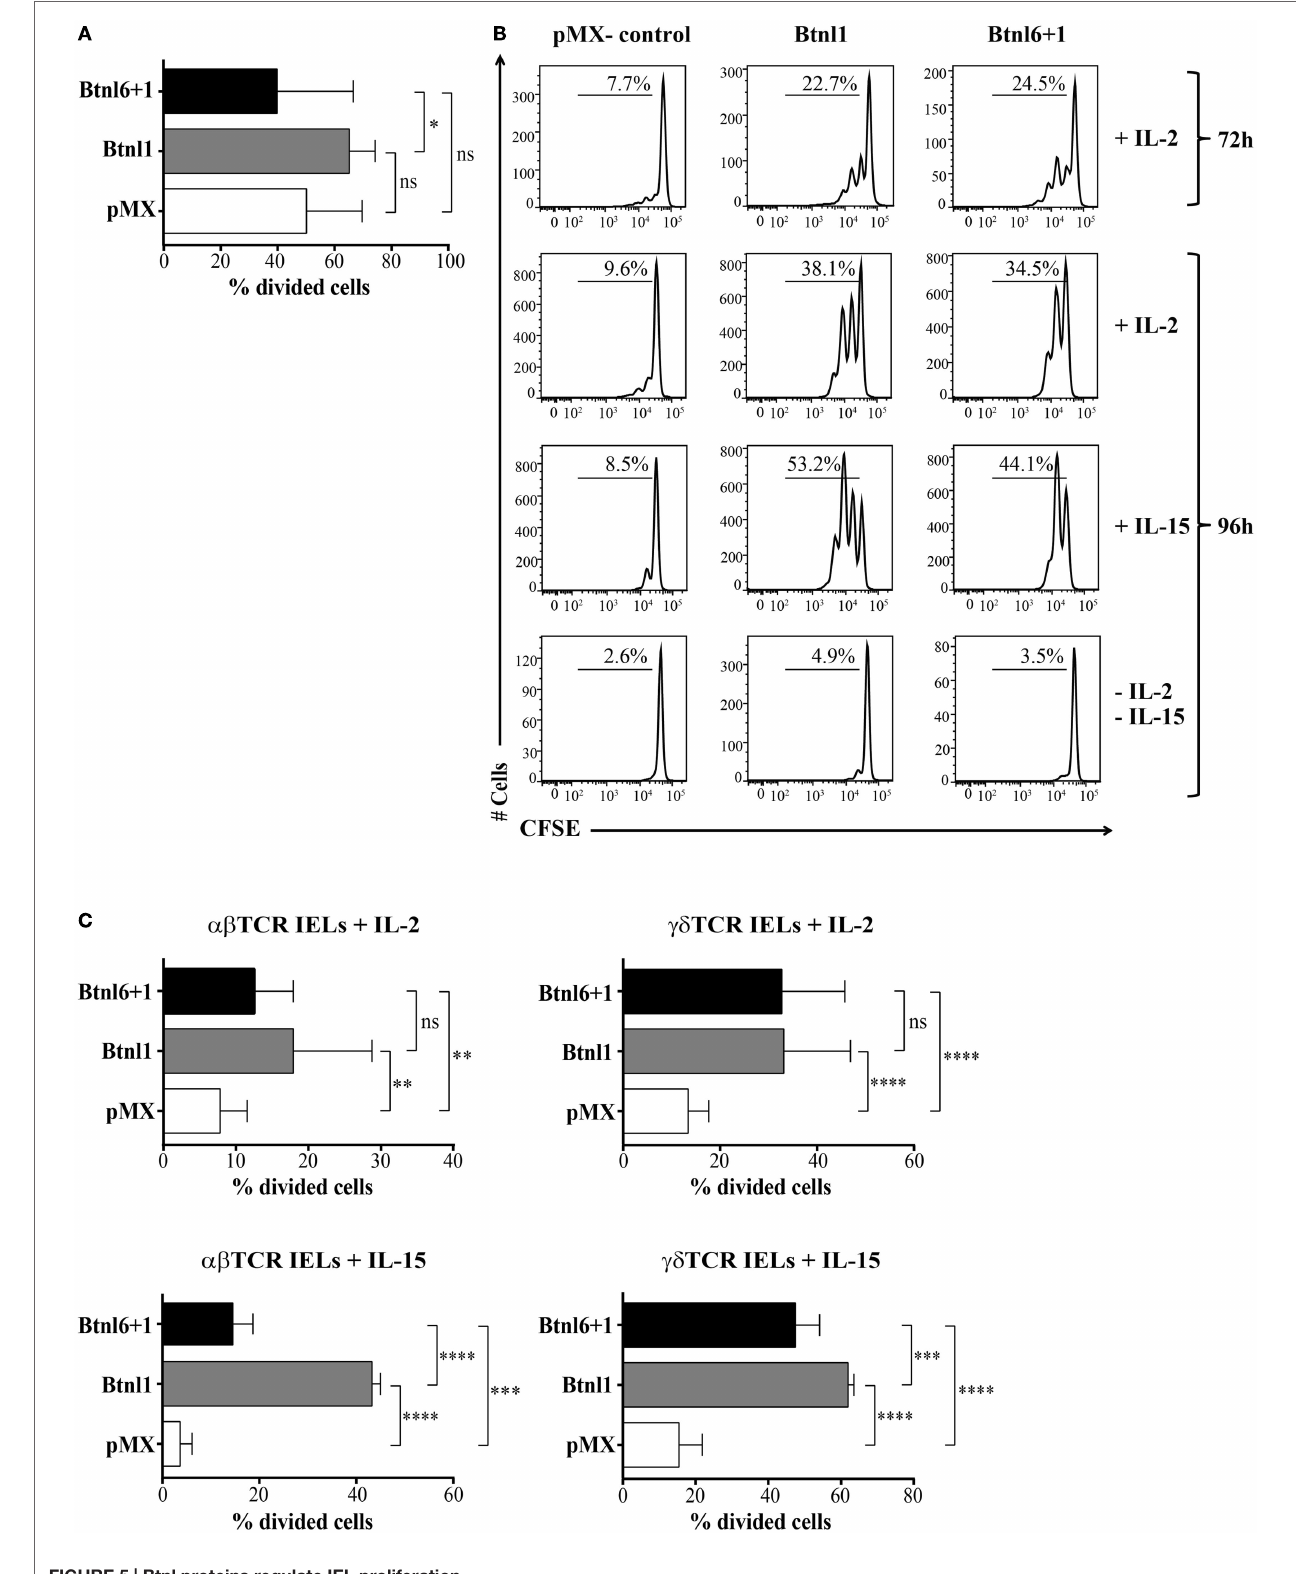
FigUre 5 | Btnl proteins regulate iel